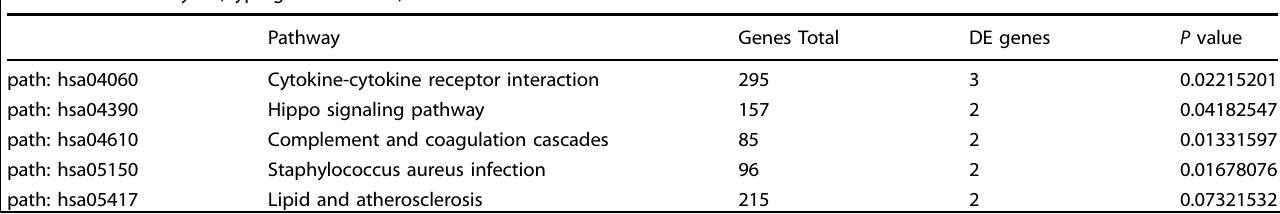
Table 1. KEGG analysis (hypergeometric test).